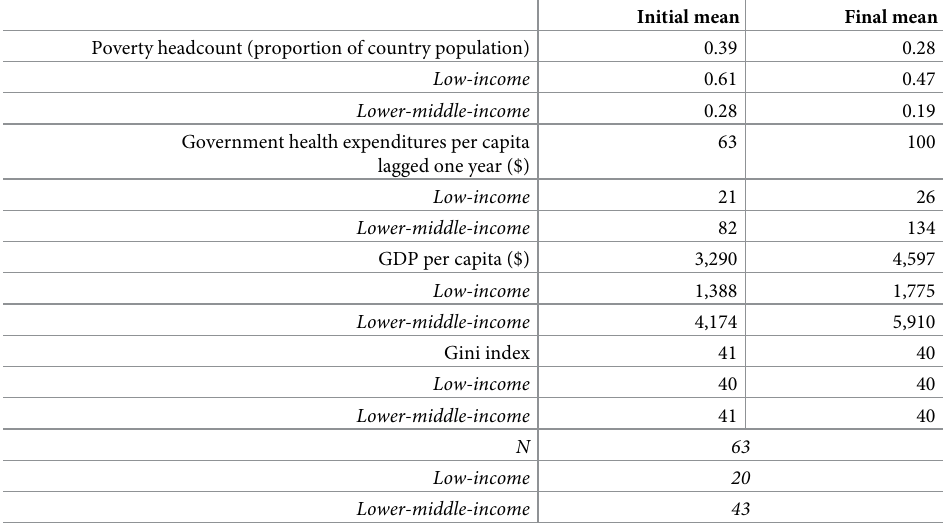
Table 1. Summary statistics of the sample of low- and lower-middle-income